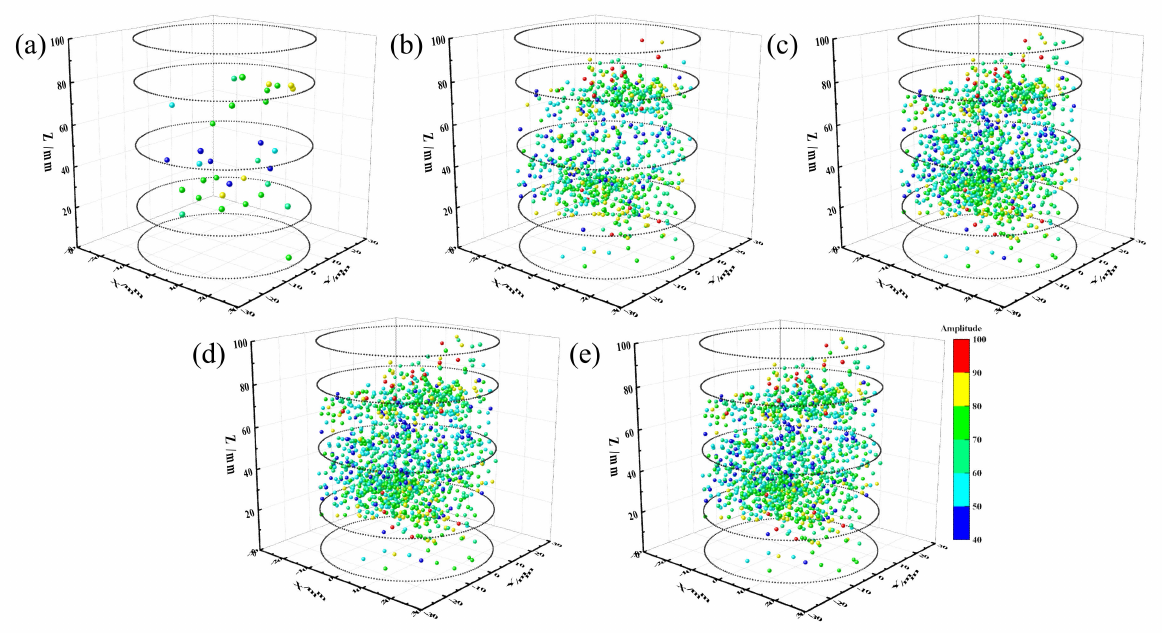
Figure 9. Spatial evolution of AE events of coal samples under different loading rates (0.6 mm/min): ( a ) crack compaction phase, ( b ) crack initiation phase, ( c ) stable crack growth phase, ( d ) unstable crack growth phase, and ( e ) post-peak failure phase.